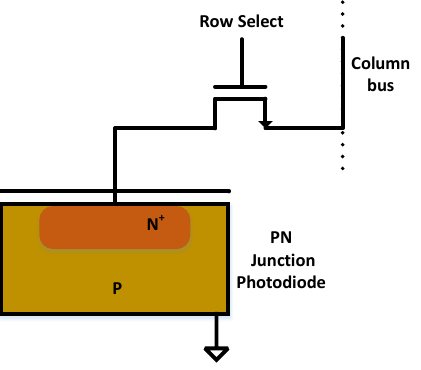
Figure 2. CMOS photo-sensing pixel architecture (adapted from